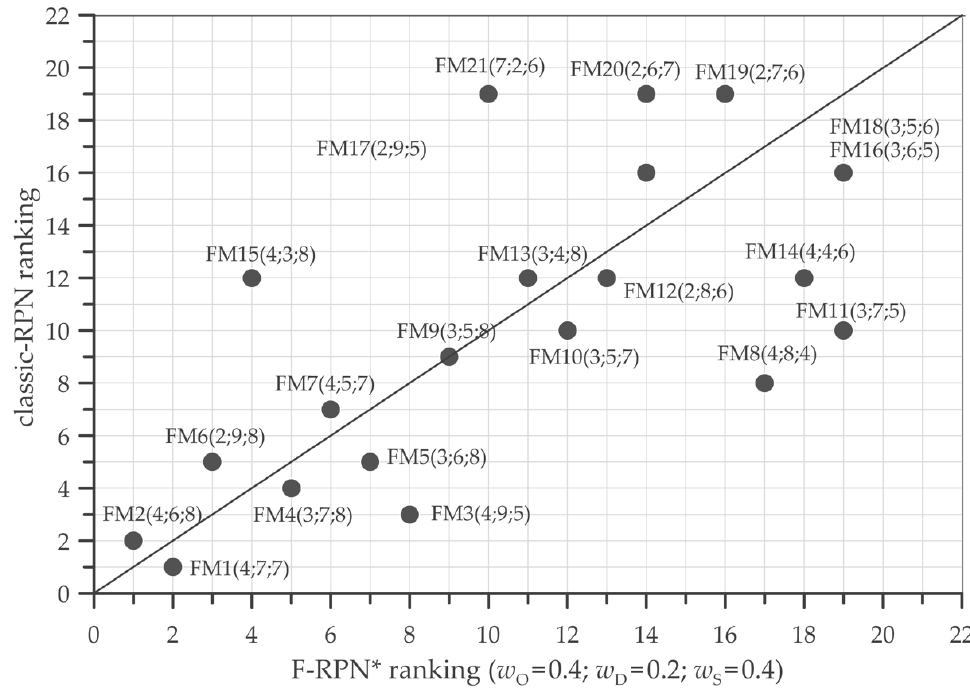
Environments 2022 , 9 , x FOR PEER REVIEW Figure 4. Comparison of rankings classic-RPN vs. Fuzzy-RPN*, obtained using weights of Equation (4).